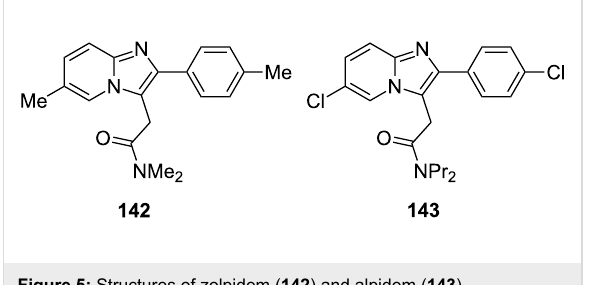
Figure 5: Structures of zolpidem ( 142 ) and alpidem ( 143